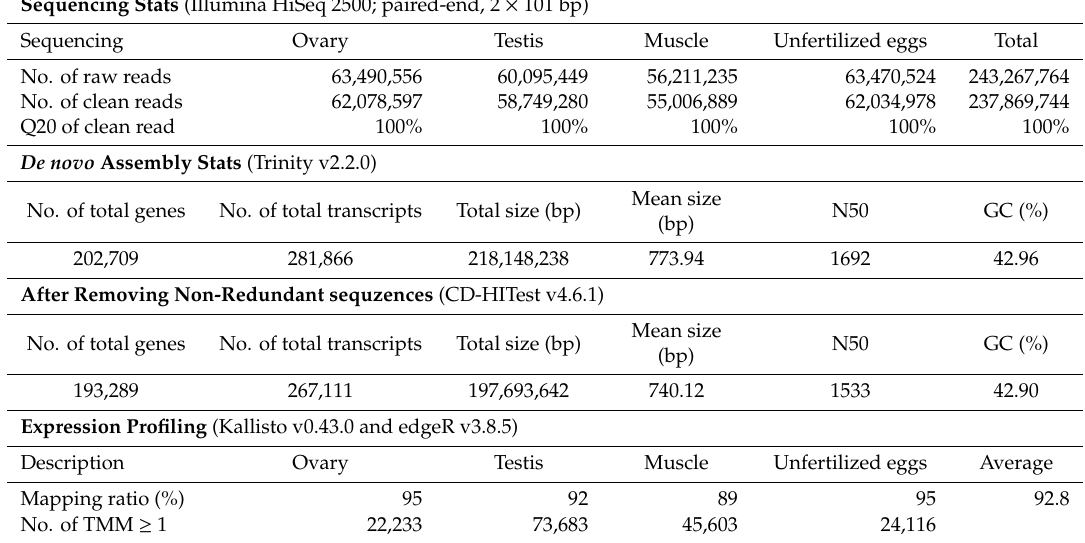
Table 1. Statistics for sequencing, de novo assembly, and completeness assessment of the M. anguillicaudatus